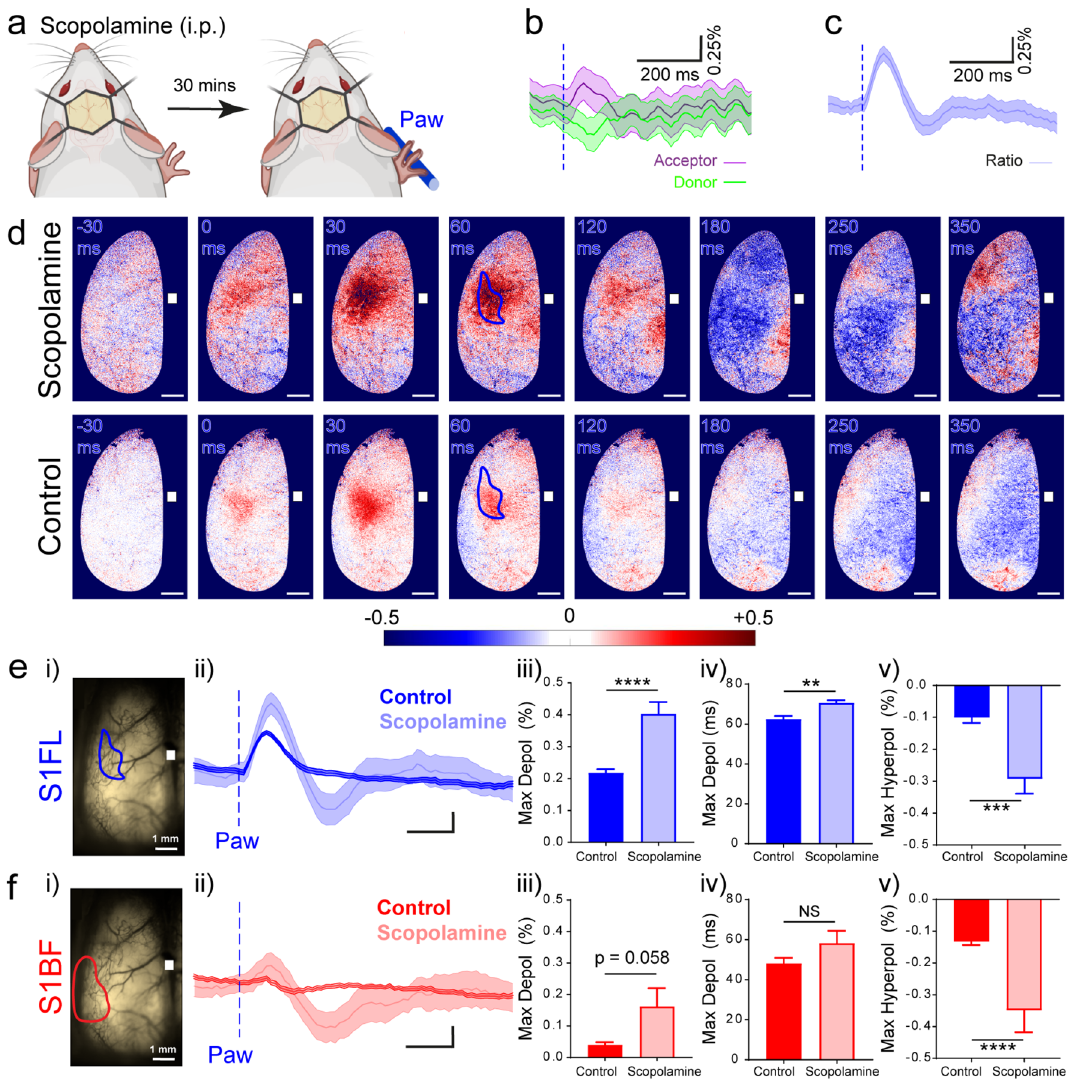
Figure 3. Systemic scopolamine, a cholinergic antagonist, re-shapes the amplitude and timing of tactile-evoked voltage responses in cortical sensory areas (“Results”; “Discussion”). ( a ) Schematic methods. Mice received a single intraperitoneal (i.p.) injection of 1 mg/kg of scopolamine, 30 min later mice were head-fixed and imaged during paw stimulation. Mouse images created with Biorender.com. ( b ) Average sensory-evoked donor (green) and acceptor (purple) fluorescence responses (ΔF/F) induced by paw stimulation spatially averaged over the contralateral forelimb area (S1FL) in scopolamine-treated mice. Vertical dashed line indicates stimulation onset. (n = 17 trials, 6 mice). ( c ) Average sensory-evoked voltage responses, ratio ΔR/R, from the same trials as in B. Vertical dashed line indicates stimulation onset. ( d ) Sensory-evoked voltage maps in response to paw stimulation 30 ms before (− 30 ms), at the stimulation time (0 ms) and selected times after stimulation in control and scopolamine-treated mice. Maps contain the same data as the traces in E and F. Depolarised pixels red, + 0.5% ΔR/R and hyperpolarised pixels blue, − 0.5% ΔR/R. Scale bar 1 mm. Bregma is a white square. (Scopolamine n = 17 trials, 6 mice. Control n = 58 trials, 6 mice). Side by side videos of responses to paw stimulation in mice before and after scopolamine-treatment can be found in Supplementary Video 2. ( e ) (i) Through-skull cranial window with mapped S1FL according to “The Mouse Brain in Stereotaxic Coordinates” 48 , relative to bregma, shown with a white square. (ii) Average voltage traces from the S1FL area in response to paw stimulation in control and scopolamine-treated mice. Vertical dashed line represents stimulus onset. Scalebar 0.1% ΔR/R and 100 ms. (iii) Maximum depolarisation amplitude, Mann–Whitney test, U = 115, p < 0.0001. (iv) Time of maximum depolarization, Mann–Whitney test, U = 252, p = 0.0010. (v) Maximum hyperpolarisation amplitude, Mann–Whitney test, U = 199, p = 0.0001. ( f ) (i) Barrel field of the primary sensory cortex (S1BF) mapped as in E. (ii) Average voltage traces from the S1BF area in response to Paw stimulation in control and scopolamine-treated mice. Vertical dashed line indicates stimulation onset. Scalebar 0.1% ΔR/R and 100 ms. (iii) Maximum depolarisation amplitude, Mann–Whitney test, U = 318, p = 0.058. (iv) Time of maximum depolarization, Mann–Whitney test, U = 368.5, p = 0.111. v) Maximum hyperpolarisation amplitude, Mann– Whitney test, U = 126, p < 0.0001. Data are mean ± SEM; *** p < 0.001, NS